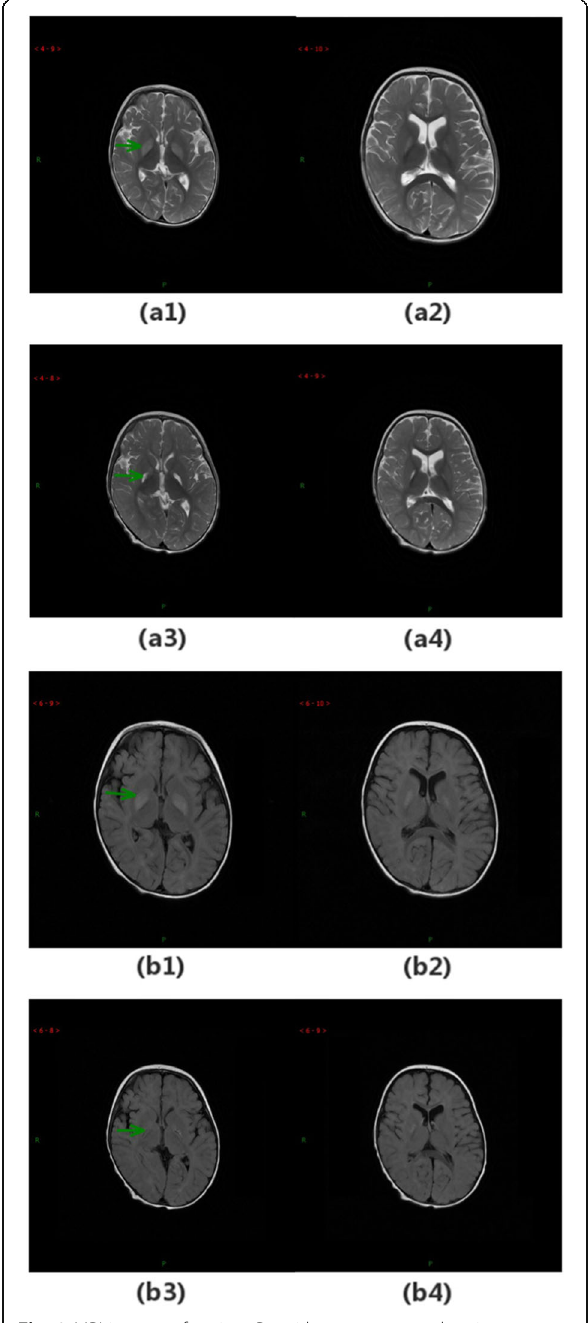
Fig. 2 MRI images of patient P5 with green arrows showing abnormal areas. Images (a1 – 4) and (b1 – 4) are T2-weighted and T2- FLAIR images, respectively. Images (a1 – 2) and (b1 – 2) are the results of the first MRI, which show symmetric abnormal signals of the bilateral basal ganglia. Images (a3 – 4) and (b3 – 4) show the results of the second MRI, which were similar to the first